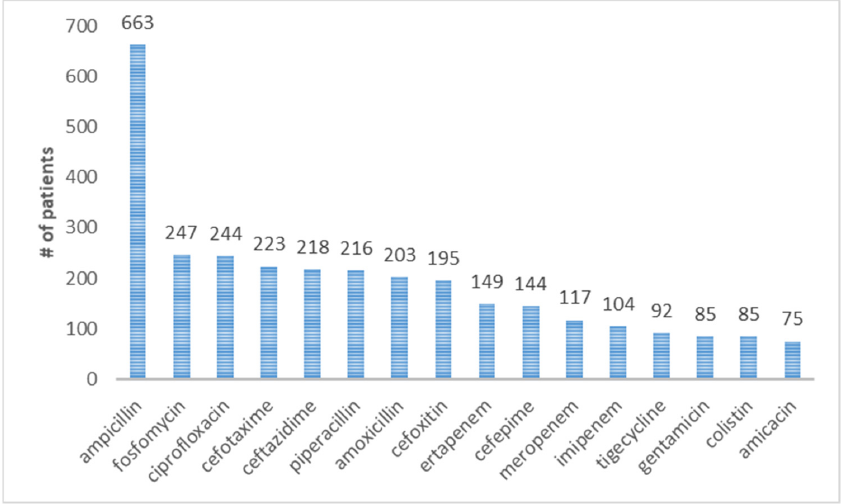
Figure 3. Antidrug resistance of the K. pneumoniae strains isolated from patients in the database described in Section